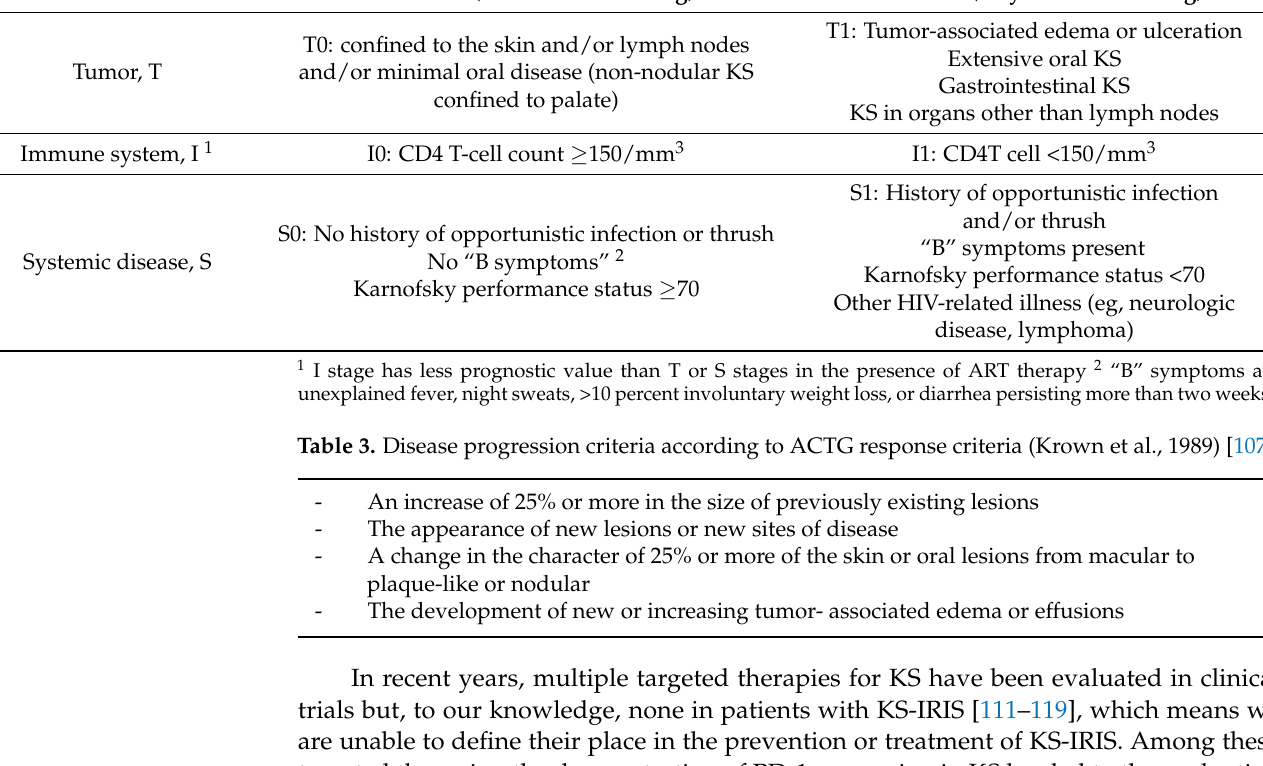
Table 2. Staging classification for AIDS-related KS (Krown et al., 1989) [107]. Criteria Good Risk (All of the Following)